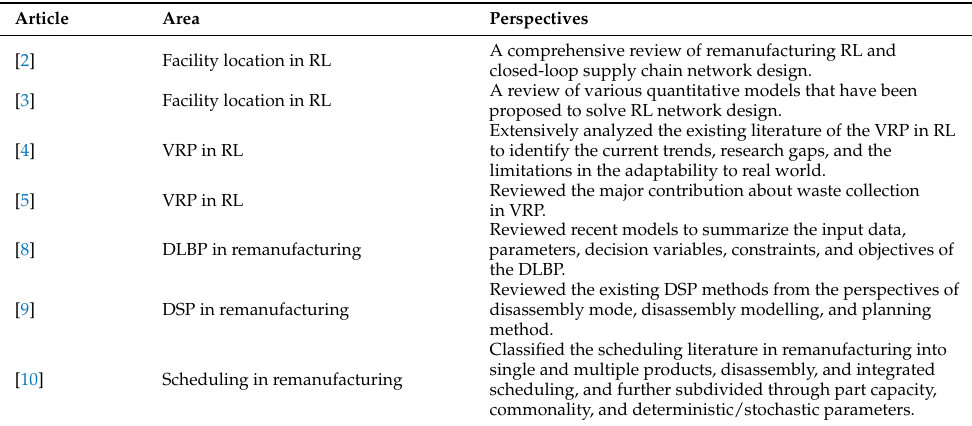
Table 1. Previous reviews about RL and